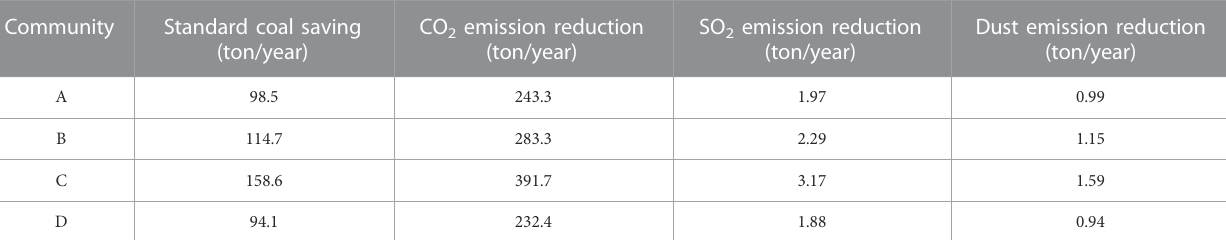
TABLE 10 Calculation table of CO 2 , SO 2 , and dust emission